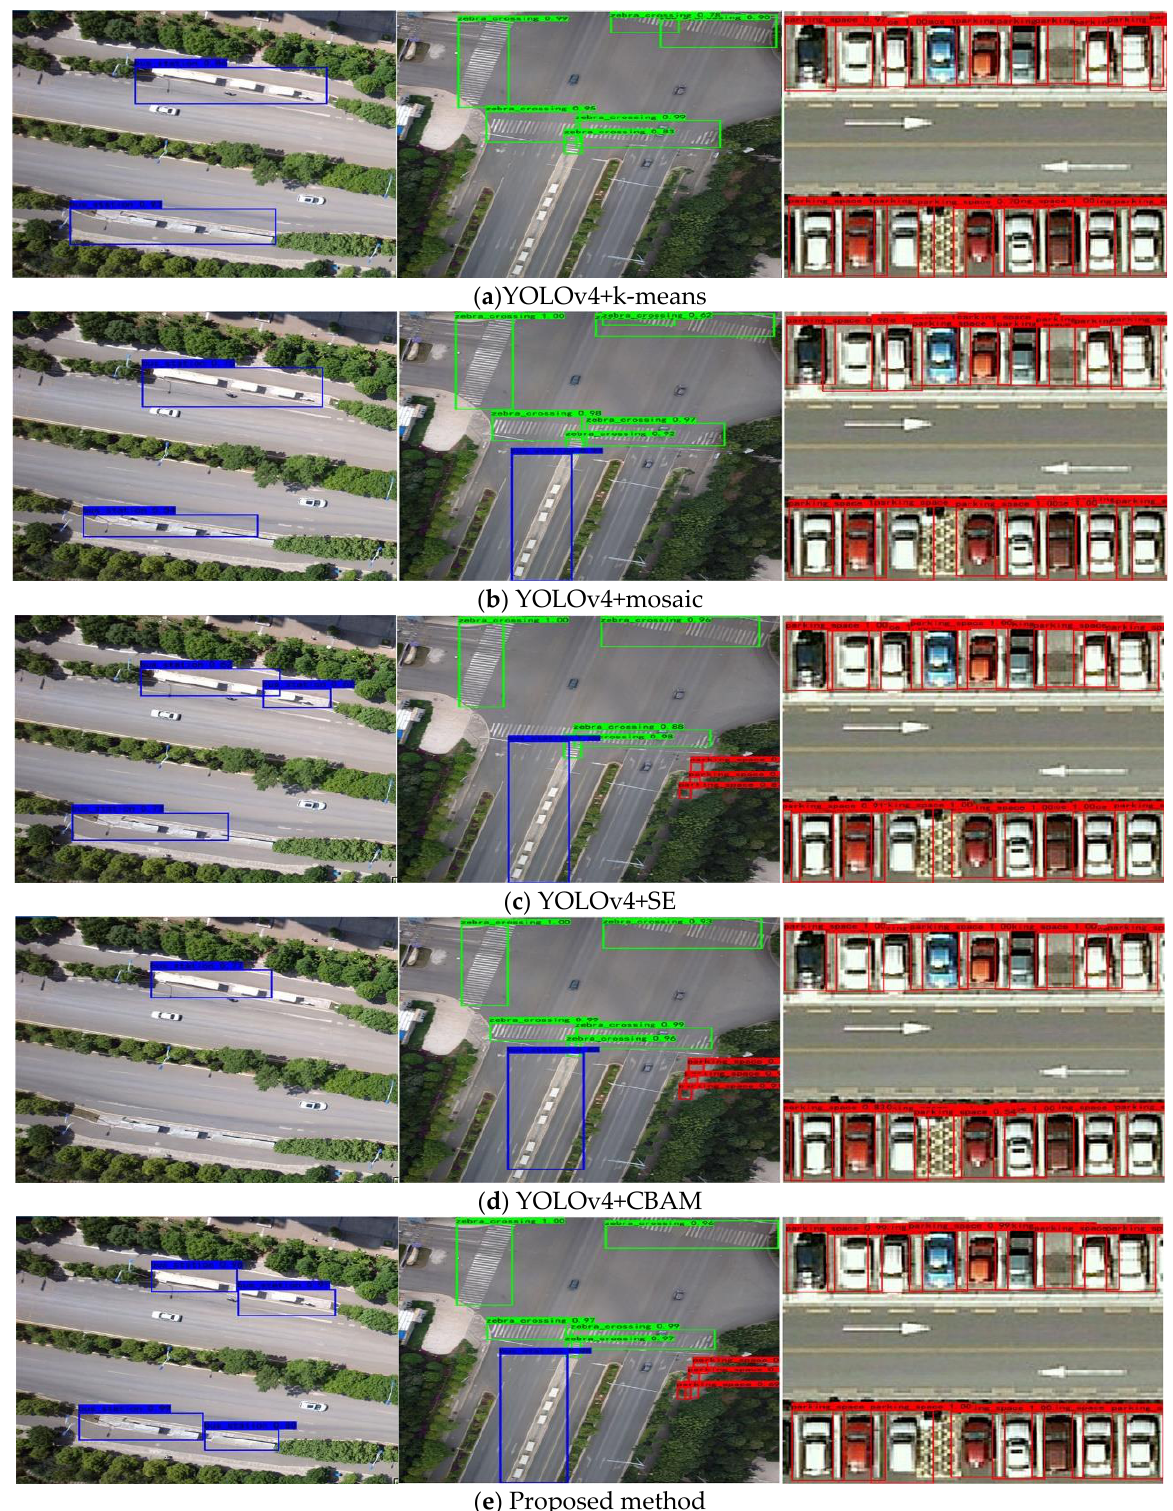
Figure 6. Plot of predicted results of ablation experiments for small scenarios, from left to right, single-element scenario, multielement scenario, and juxtaposed dense-element scenario. ( a ) YOLOv4 with k-means; ( b ) YOLOv4 with mosaic; ( c ) YOLOv4 with SE attention mechanism; ( d ) YOLOv4 with CBAM attention mechanism; ( e ) proposed method.